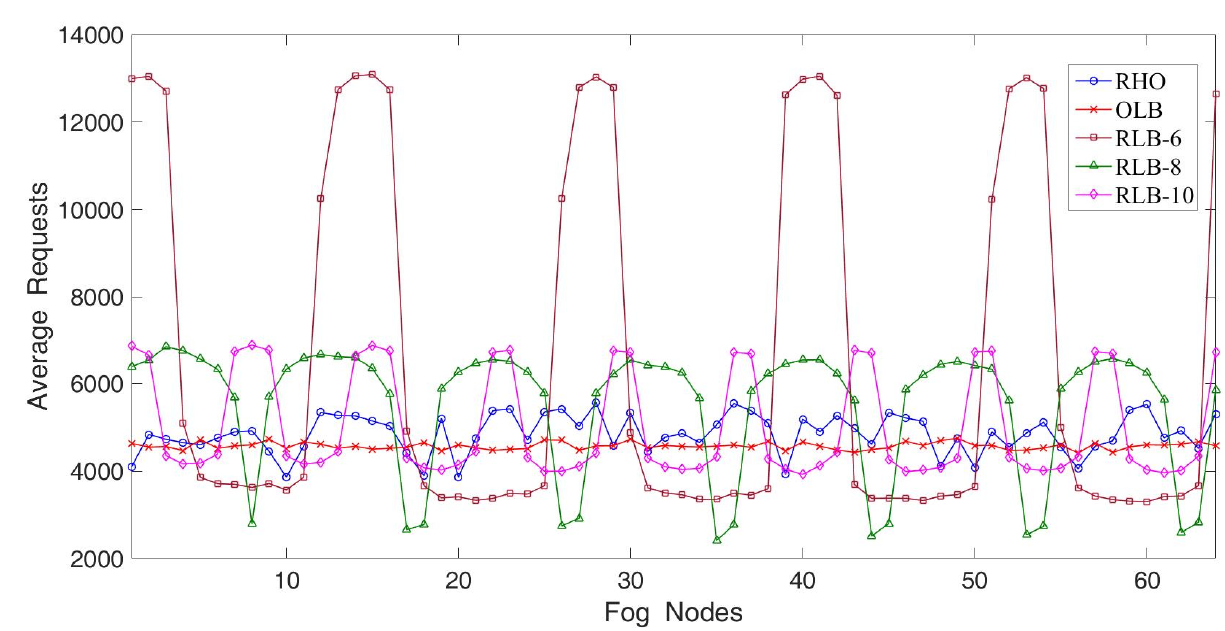
Figure 8. The average requests where sixteen fog nodes have different load conditions.